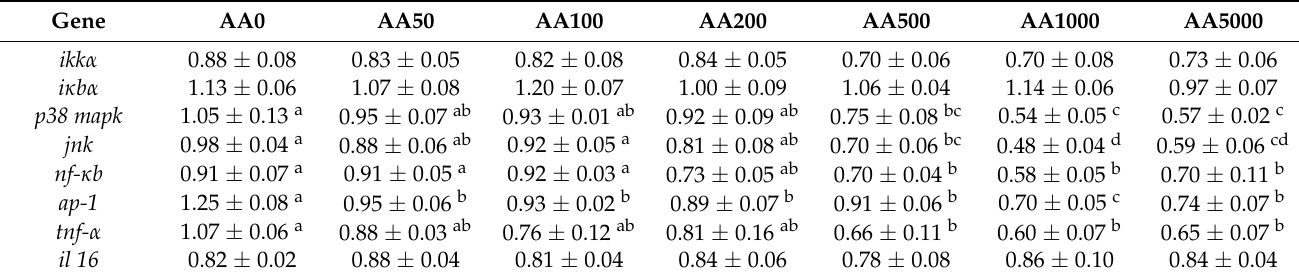
Table 7. Expression levels of ikk α , i κ b α , p38 mapk , jnk , nf- κ b , ap-1 , tnf- α and il 16 in the digestive gland of abalone ( Haliotis discus hannai ) after a 100-day feeding